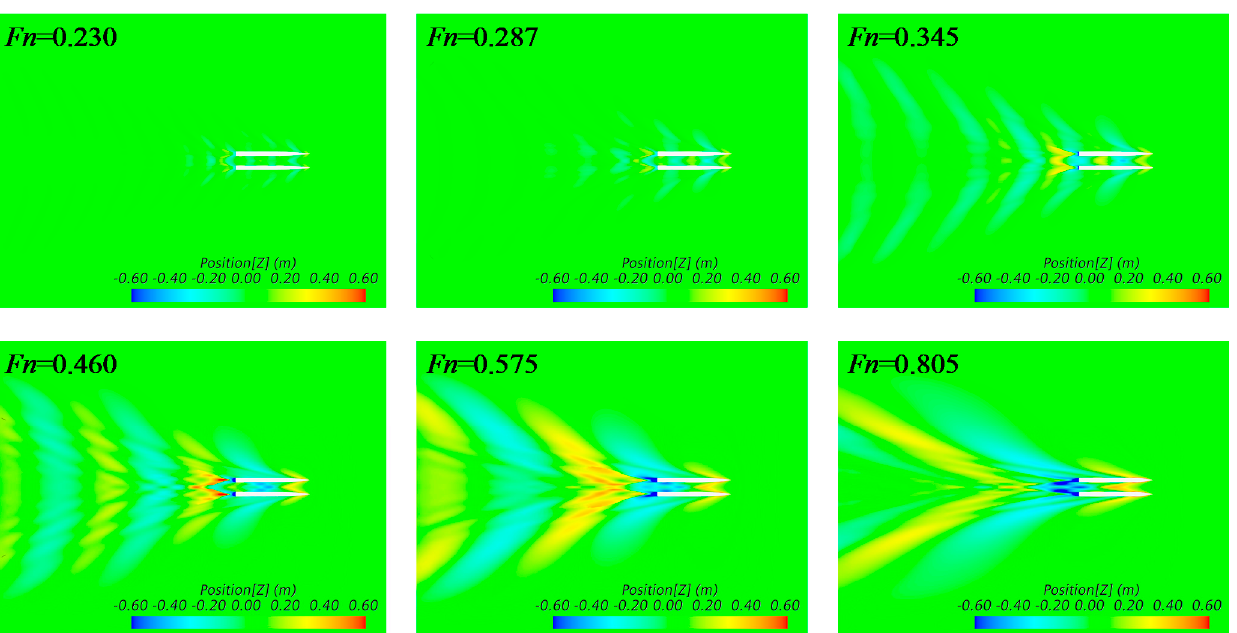
Figure 12. Wave patterns created by the London Demonstrator in deep water.